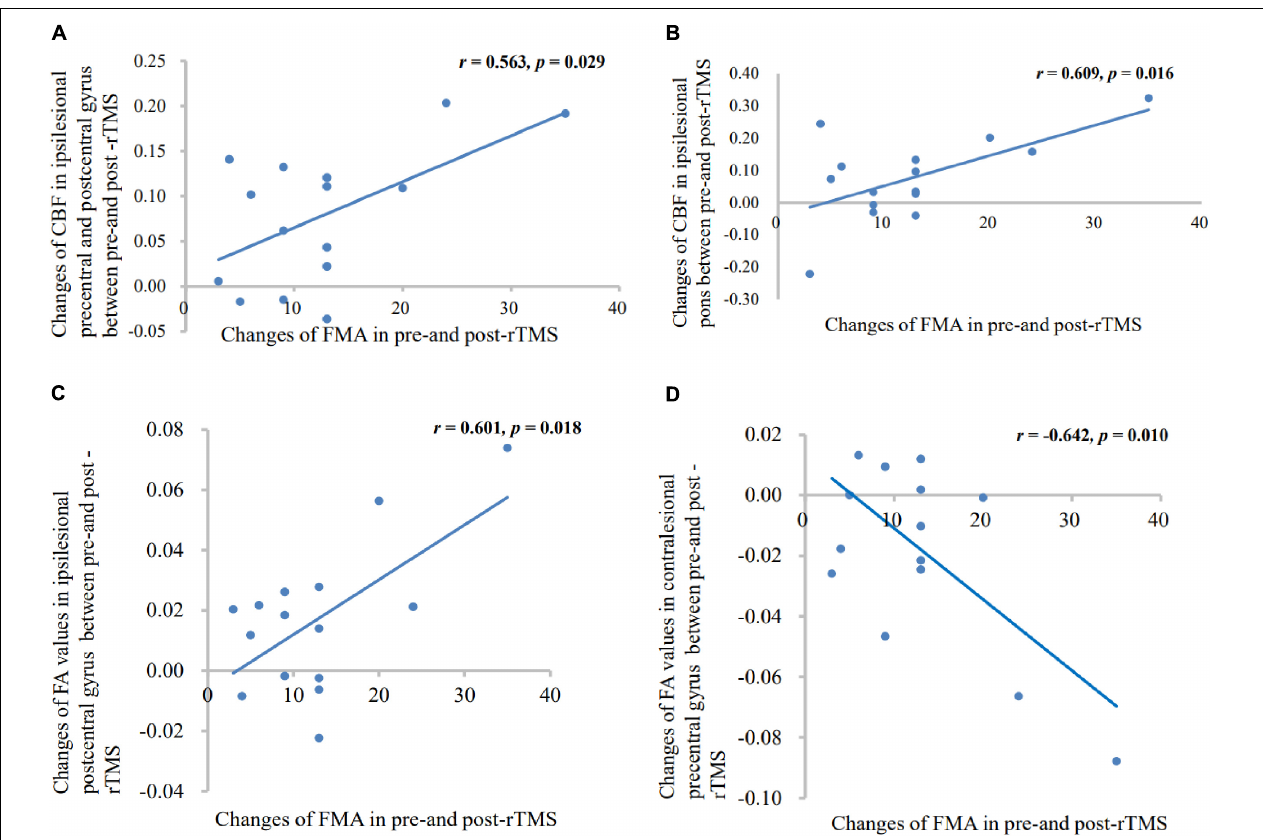
FIGURE 6 | Correlation between the altered CBF (A,B) , FA (C,D) values, and motor scores changes. Patients with rTMS treatment displayed significant positive correlations between FMA score and altered CBF values in the ipsilesional precentral gyrus, postcentral gyrus, and pons; and showed significant positive correlations between FMA score and altered FA values in the ipsilesional postcentral gyrus; and a negative correlation between FMA score and altered FA value in the contralesional precentral